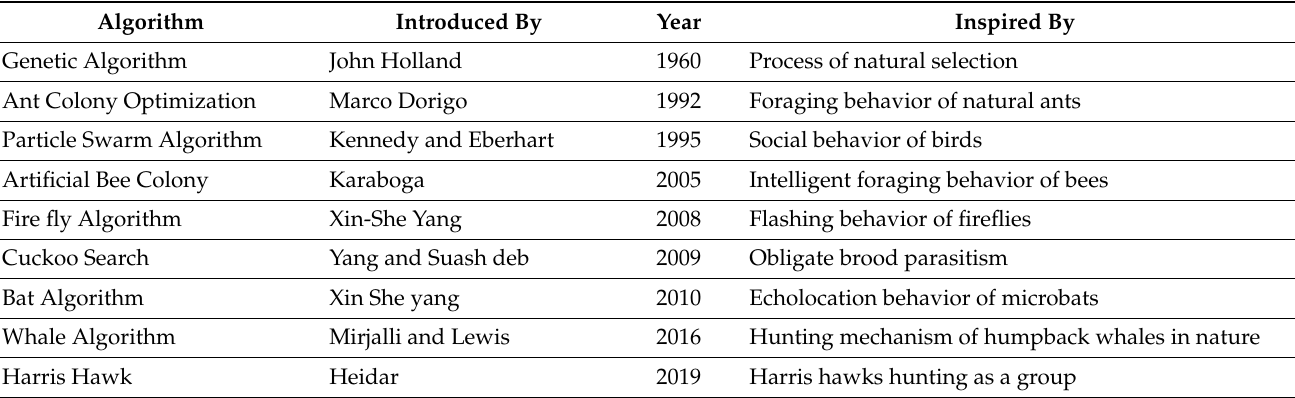
Table 2. Commonly used algorithms derived from nature for biomedical data.